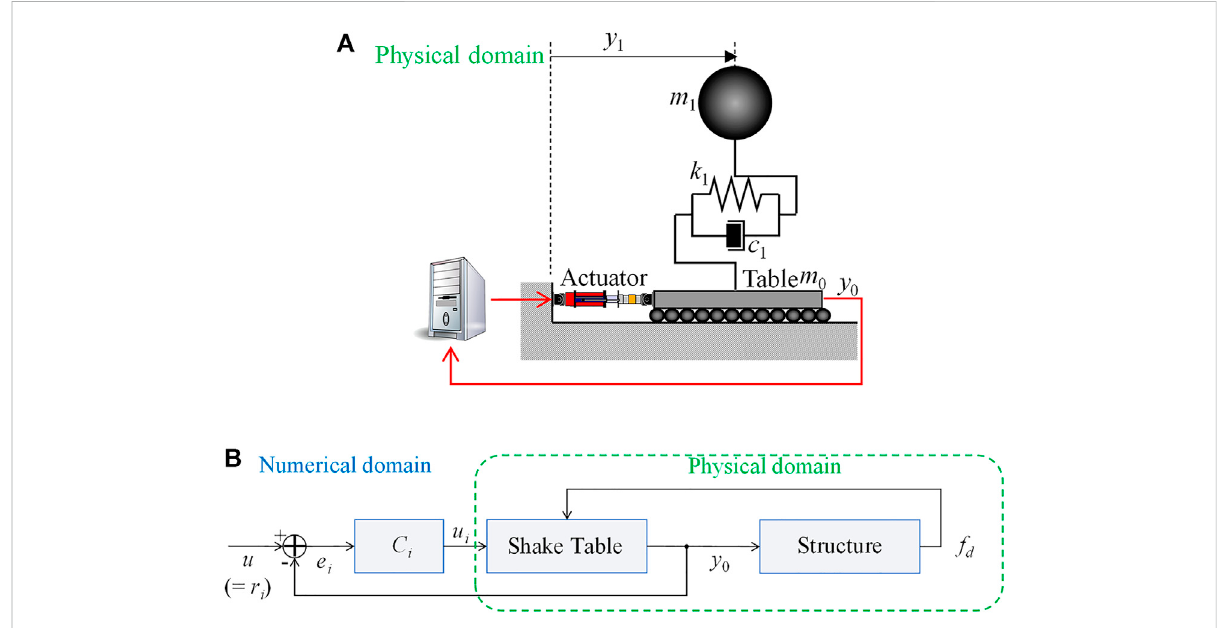
FIGURE 2 Shake table control with a structure: (A) conceptual drawing and (B) block diagram.